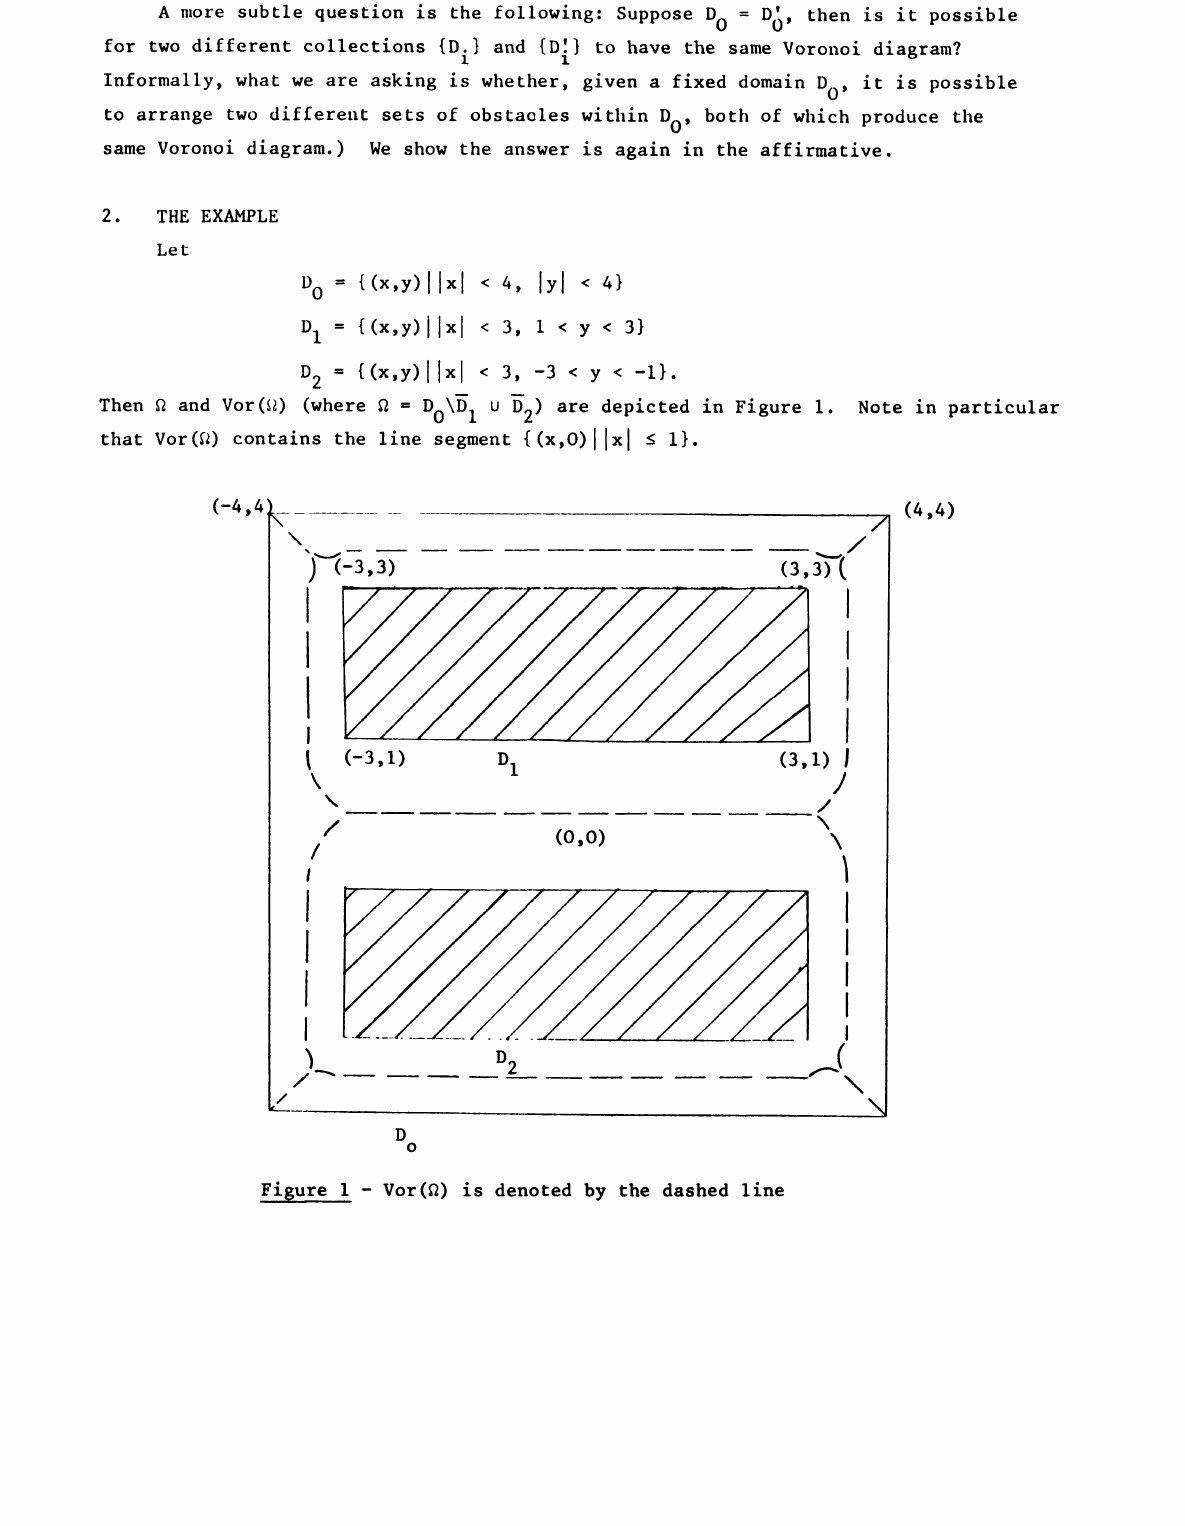
Figure I Vor() is denoted by the dashed